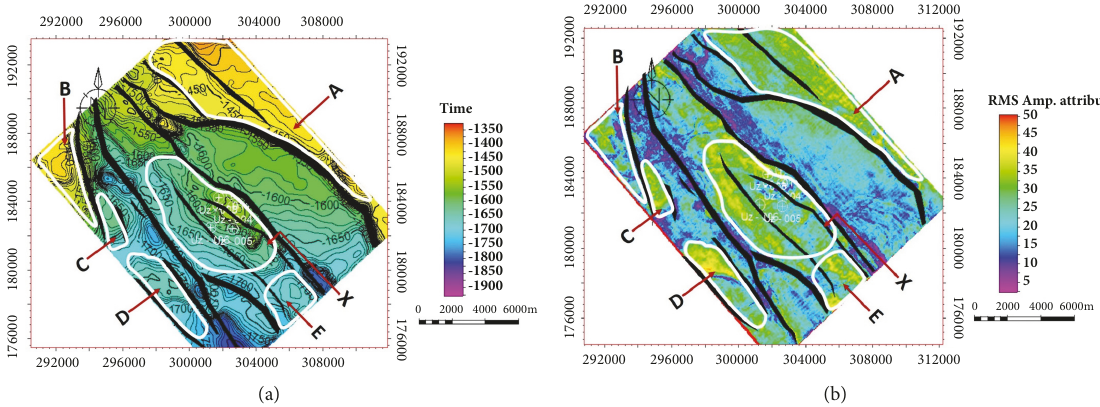
Figure 10: (a) Structural depth top map of reservoir D3100 showing identified prospective zone. (b) Amplitude (root-mean-squareamplitude attribute) extracted/generated map of D3100 reservoir showing identified hydrocarbon leads (A, B, C, D, and E) away from the producing zone “X” (Note that zone “X” is a prospect, which has been drilled already).